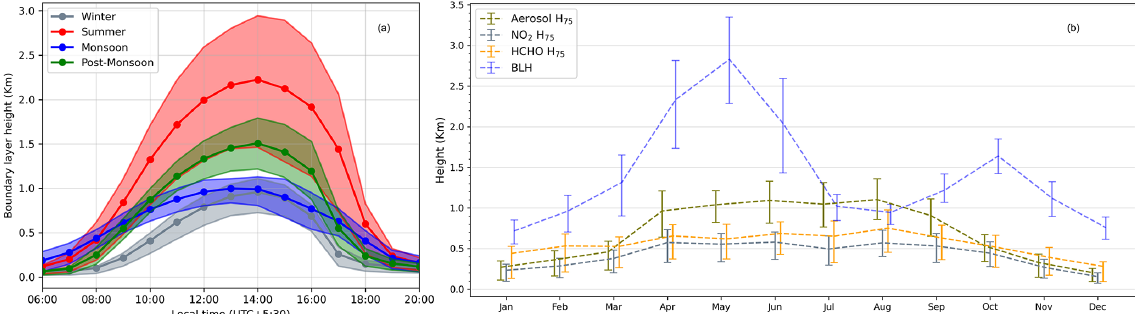
Figure 6. (a) Diurnal evolution of the hourly means ERA5 boundary layer height (BLH) at Mohali for the four major seasons of the year. (b) Mean afternoon time (between 12:00 and 15:00LT) profile height (with 75% of the total amount below) for aerosols, NO 2 , and HCHO and the ERA5 BLH for different months. The upper and lower vertical error bars represent the monthly variability as 75th and 25th percentiles,